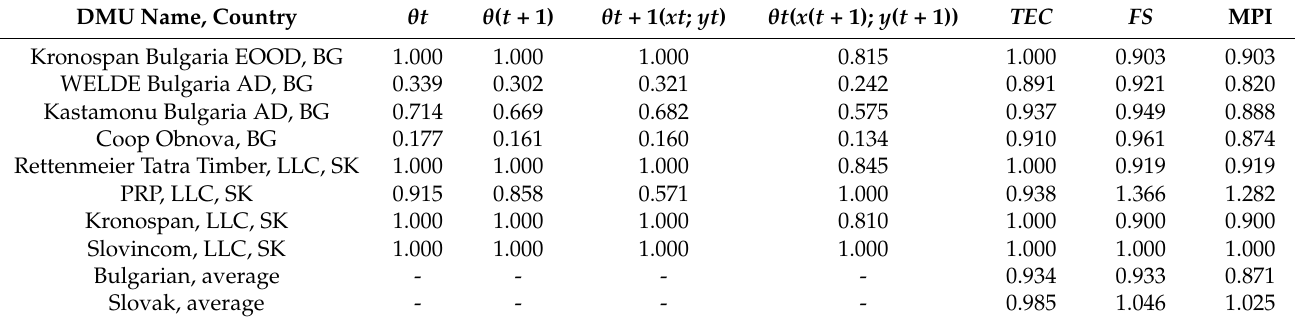
Table 9. MPI results for CCR with labour and other costs as inputs, t = 2015, t + 1 =